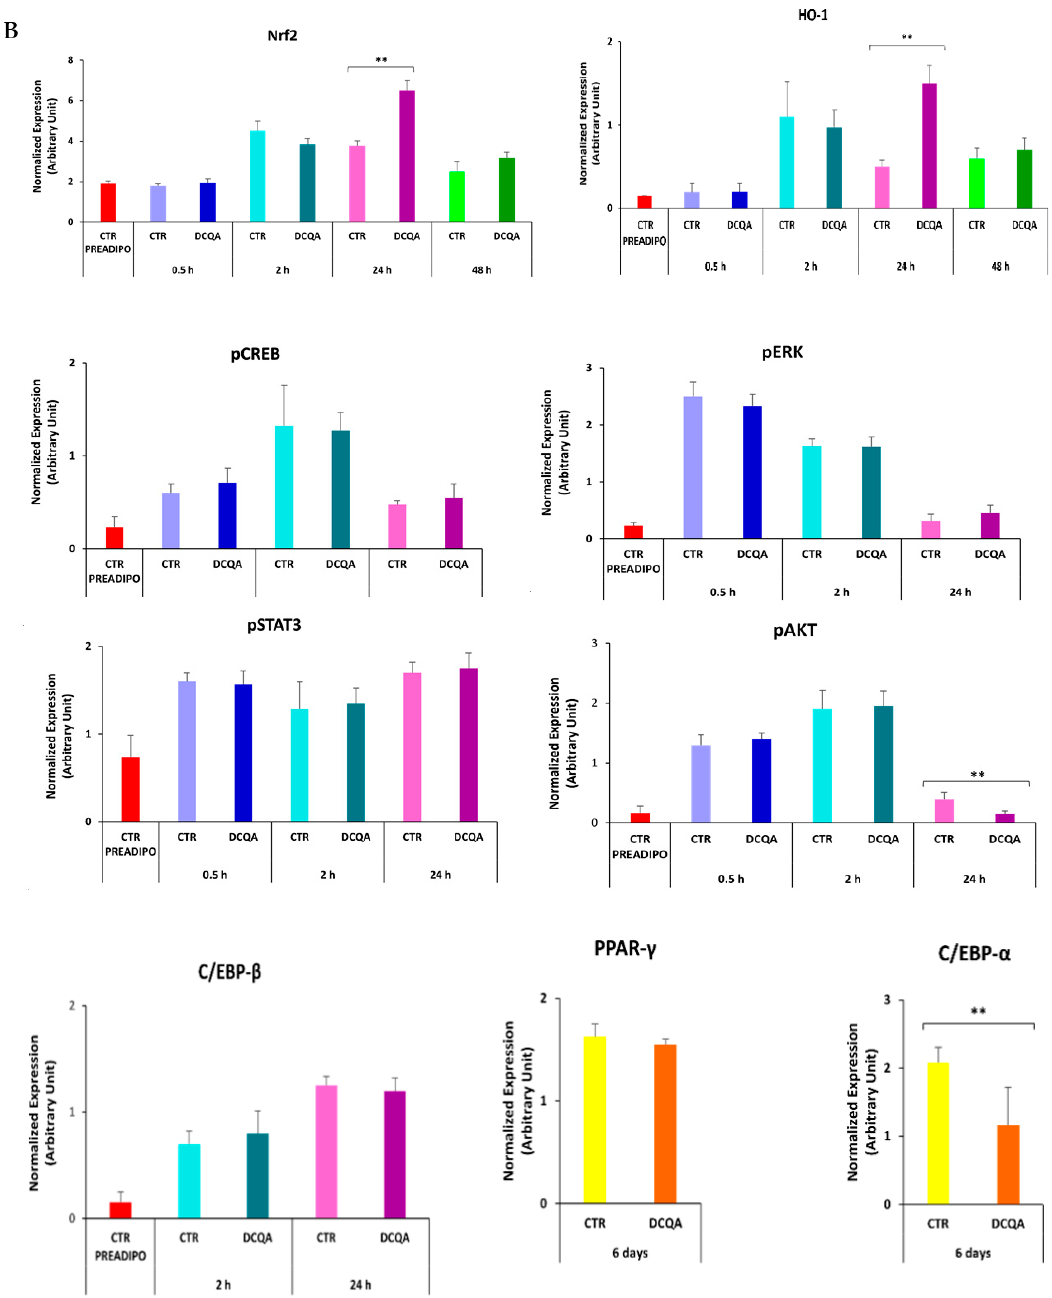
Figure 5. The immunoblots show the expression level of proteins belonging to signaling pathways elicited after MDI stimulation. ( A ) 3T3-L1 cells were induced with MDI for 0.5, 2, 24, 48 h and 6 days, and pre-treated with or without 10 µM DCQA. Immunoblots showed that Nrf2, HO-1, pCREB, pERK and pAkt were activated in comparison with 3T3-L1 cells not stimulated to differentiate. No significative differences are registered between controls and DCQA-treated cells 0.5 and 2 h after MDI stimulation. At 24 h after MDI stimulation, pAkt level decreased, whereas Nrf2 and HO-1 levels increased in DCQA-treated cells vs. controls. At 48 h after MDI stimulation, HO-1 level fell to the level of those registered in the controls at 24 h. At 6 days after MDI stimulation, dissimilarly to PPAR- γ , C/EBP- α expression level decreased in DCQA-treated cells. ( B ) Data from densitometric analyses were normalized with the PARP/ β -actin expression. The quantification of protein expression of three independent experiments is shown. Data statistically significant vs. each control sample are indicated. (** p < 0.01).